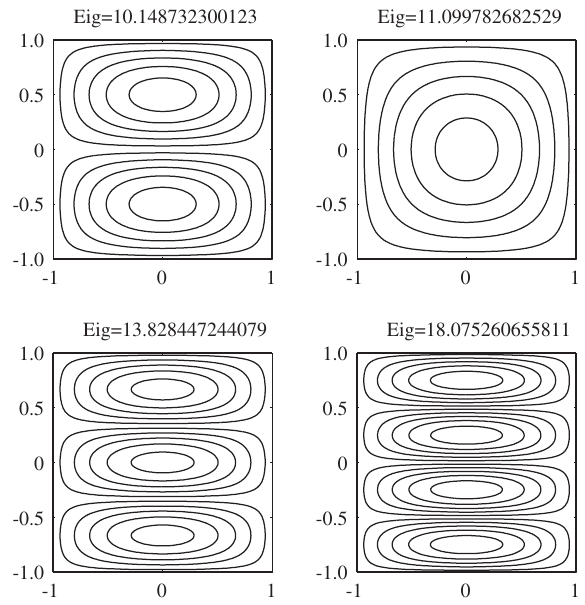
Figure 4 First four buckling modes for a uni-axial buckling load of four-layer [0/90/90/0] SSSS laminated plate, using a 11 2 points grid and the higher-order theory.